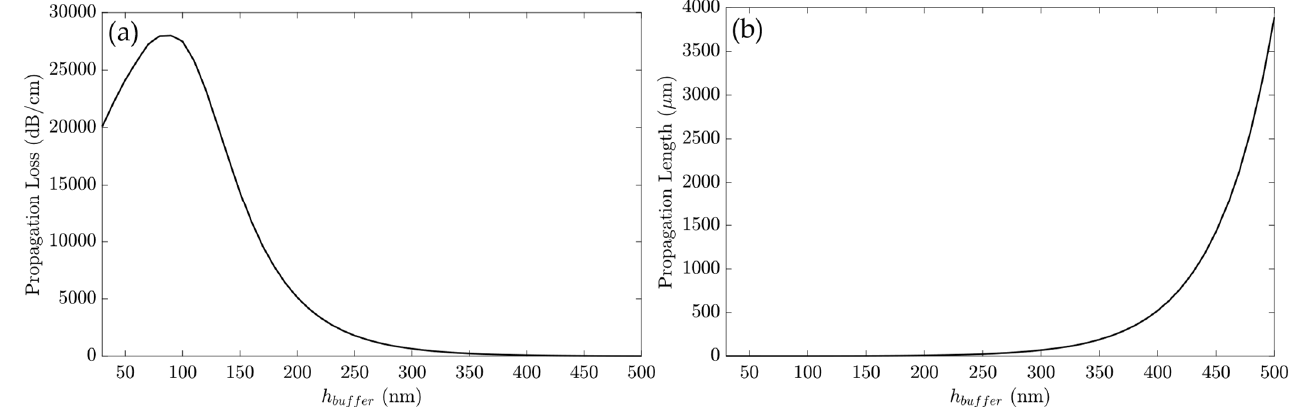
Figure 7. The Cytop layer between the waveguide and the gold layer. ( a ) α versus h buffer and ( b ) PL versus h buffer .